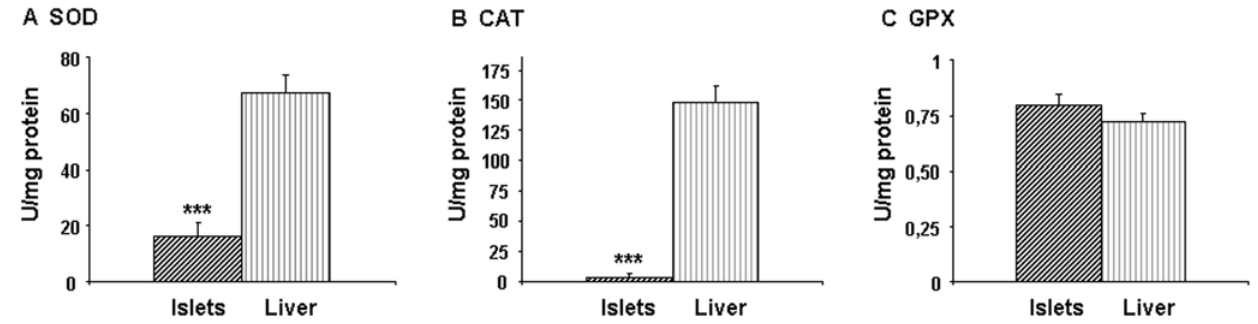
Figure 1. Antioxidant enzyme activity in fetal pancreatic islets and liver. (A) SOD, (B) CAT, (C) GPX. Results are expressed as means 6 SEM; n=5–6 independent experiments. ***p , 0.001 islets vs liver.